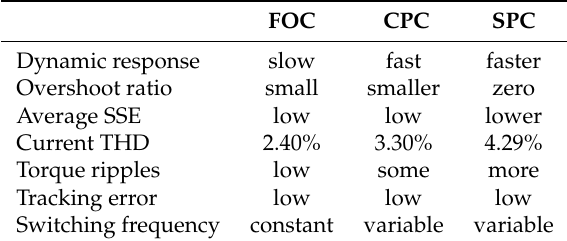
Table 3. Comparison between the FOC, CPC, and